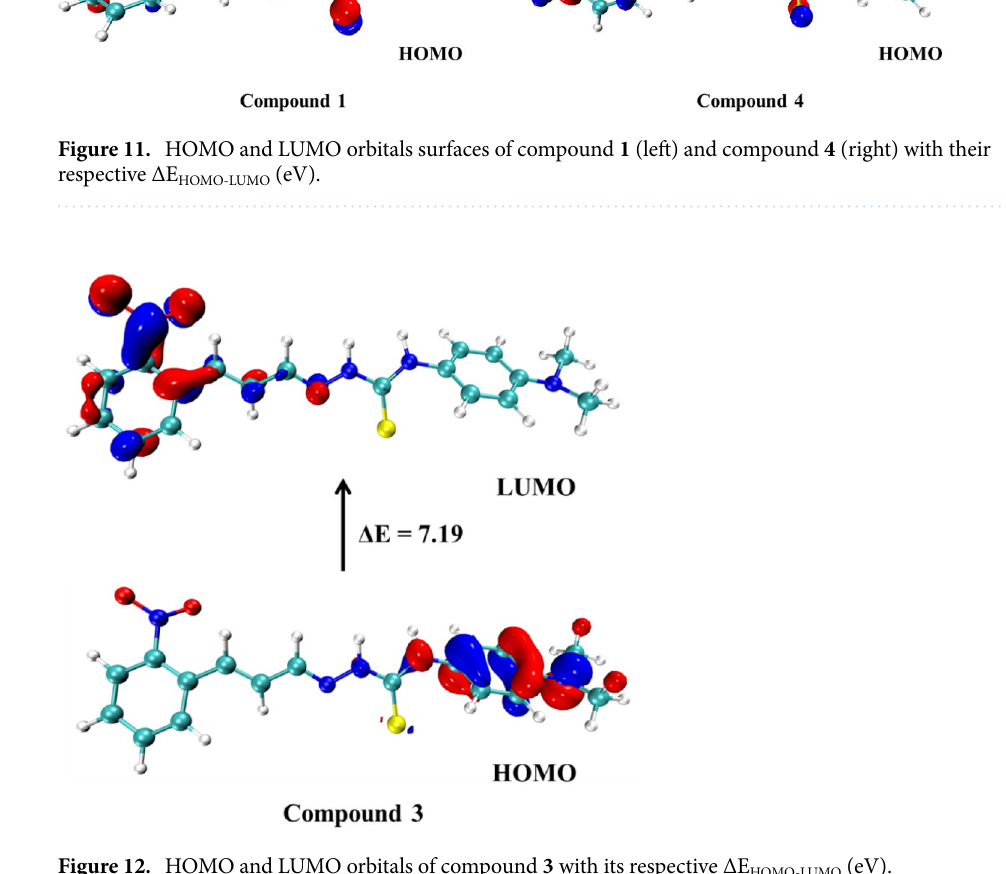
Figure 12. HOMO and LUMO orbitals of compound 3 with its respective ΔE HOMO-LUMO (eV).